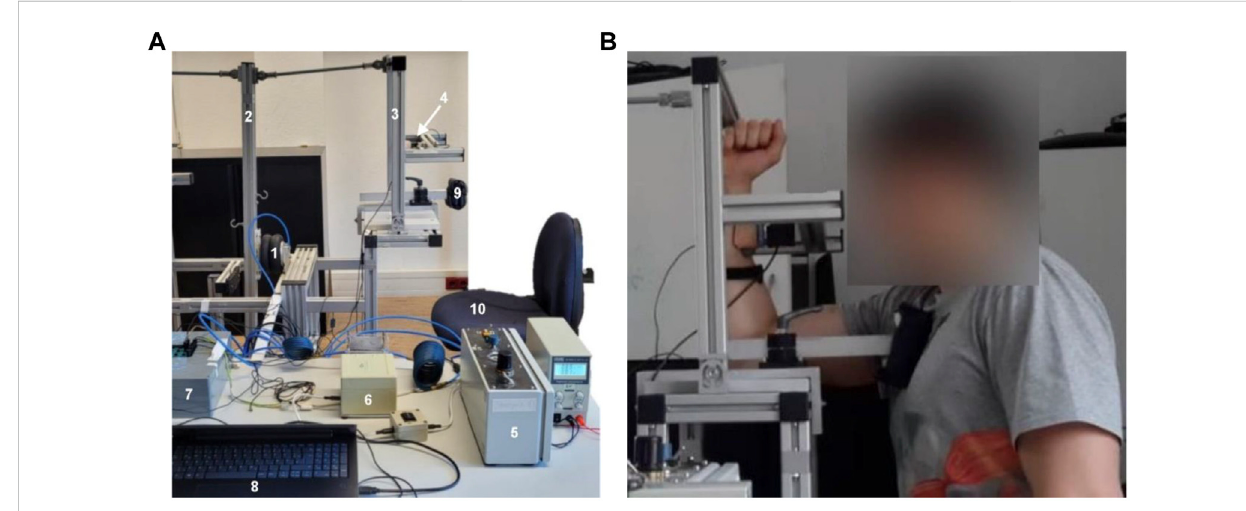
FIGURE 1 Measurementsystemandposition. (A) Measurementsystemconsistsofabellowscylinder(1),leverI(2),leverII(3),interfacewithastraingauge(4),a control device including a throttle and pressure sensor (5), an additional motor throttle (6), an A/D converter (7), a measuring laptop (8), a cushion for thorax fi xation (9), and a seating chair for the participant (10). The acceleration sensors and the compressor are not depicted. (B) Starting position to record the AF of the elbow fl exors and the